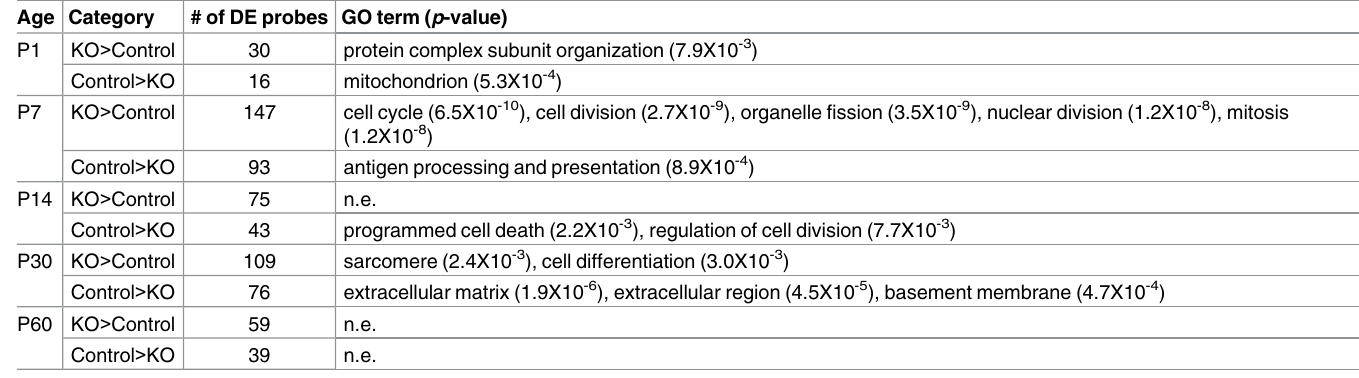
Table 3. DE genes between control and Sox6 KO